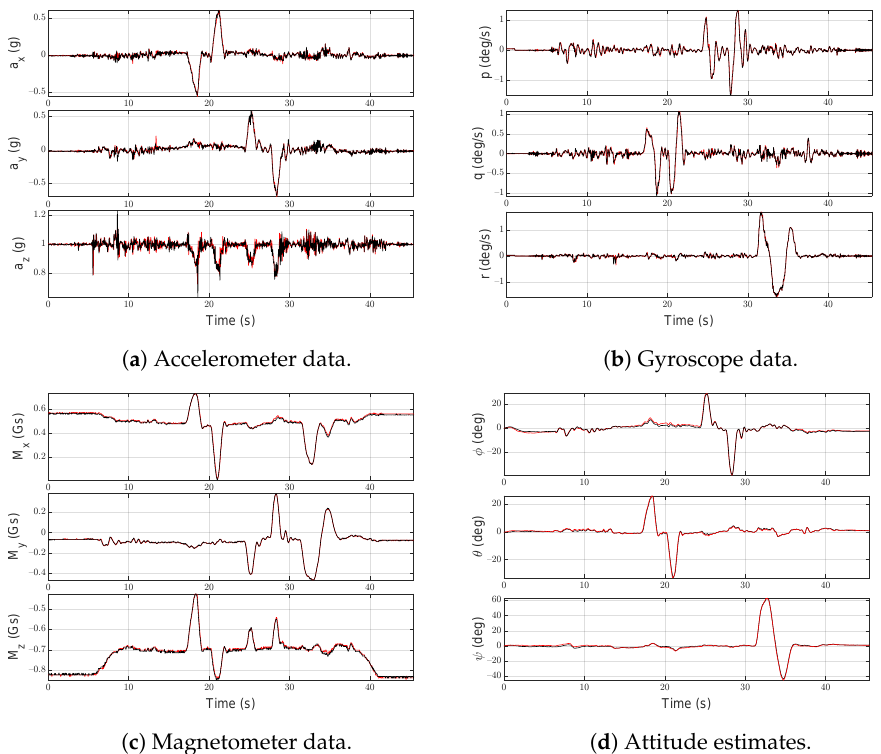
Figure 6. Data gathered from both IMUs during the flight test in the absence of faults. Black lines indicate data gathered by IMU-1 while red lines are for